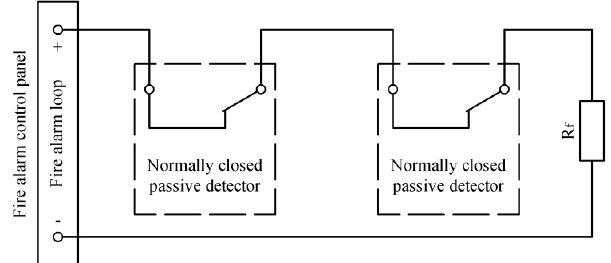
Figure 4. Wiring diagram for normally-locked FA in a two-wire loop R f – final resistor